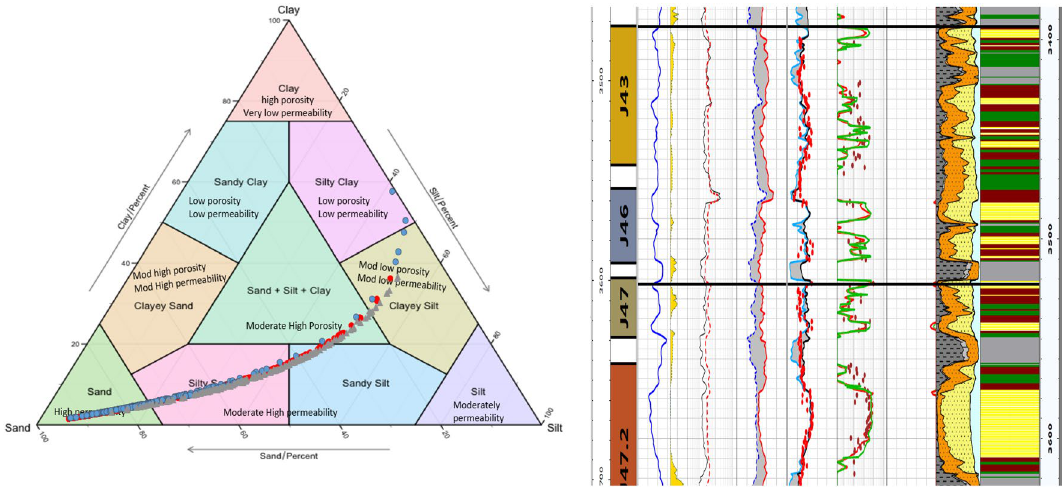
Fig. 10 Ternary diagram for the cored interval in the study well (Temana